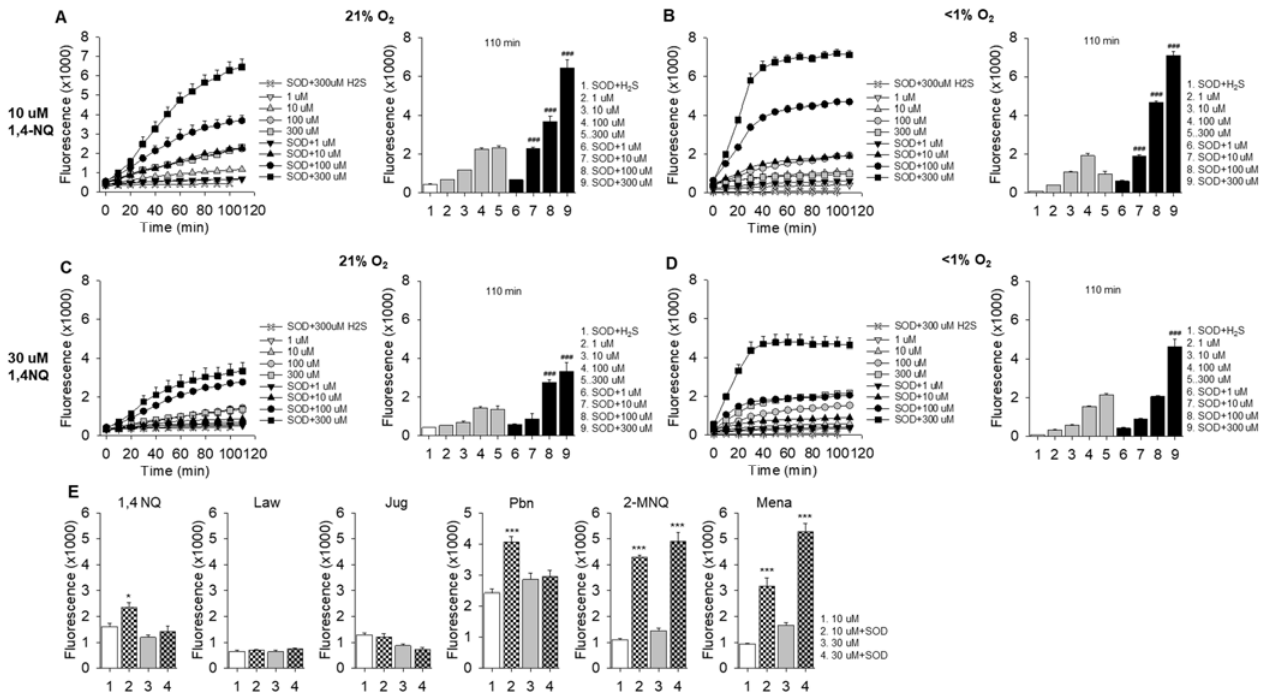
Figure 3. ( A – D ) Effects of oxygen (O 2 ; 21% and <1%) and superoxide dismutase (SOD; 0.1 µ M) on polysulfide production (SSP4 fluorescence) by 10 µ M or 30 µ M 1,4-NQ and 300 µ M H 2 S. Low O 2 had minimal effects on polysulfide production, whereas SOD increased production in both 21% and <1% O 2 . Overall polysulfide production was greater with 10 µ M than with 30 µ M 1,4-NQ. Bar graphs show fluorescence at 110 min. ( E ) Effects of SOD on polysulfide production by 10 µ M or 30 µ M NQs incubated with 300 µ M H 2 S for 120 min. Mean + SE, n = 4 wells per treatment; *, p < 0.05; ***, p < 0.001 compared to similar treatment without SOD. ###, p < 0.001 compared to maximum response.